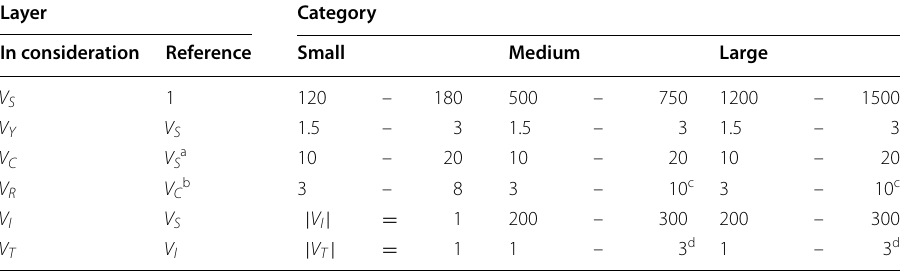
Table 1 Design parameters for graph layer